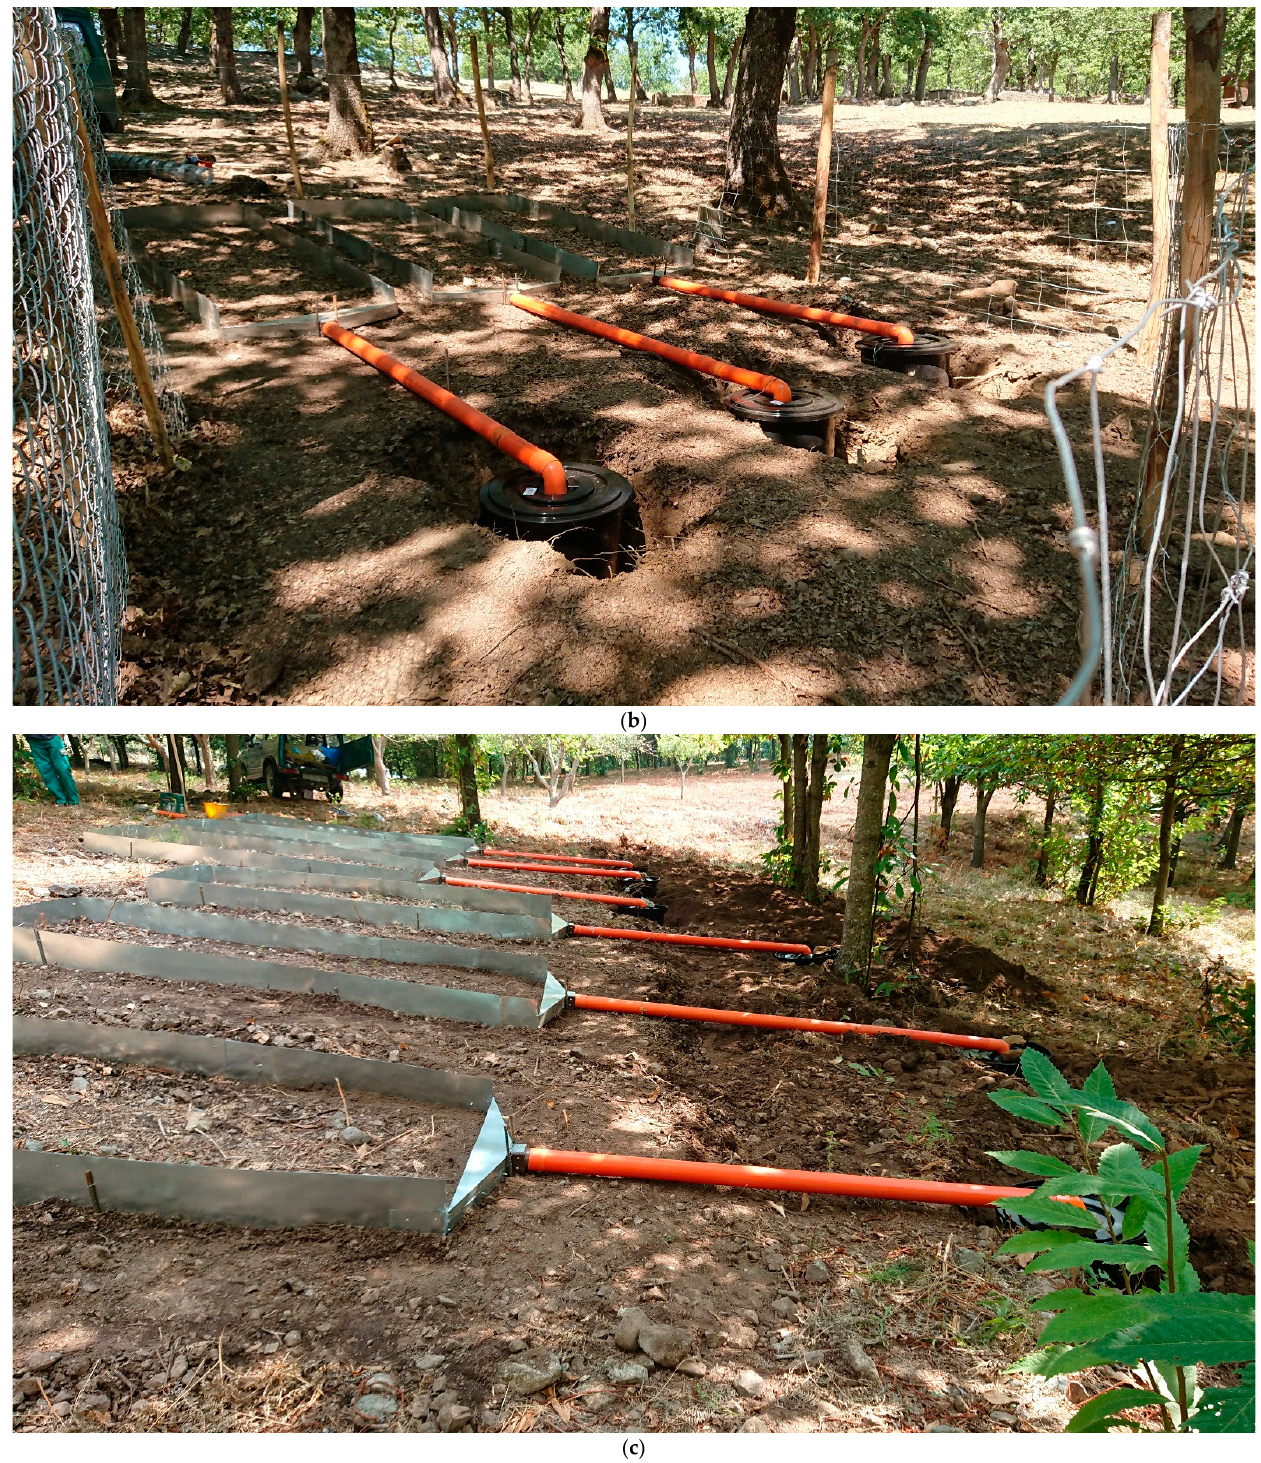
Figure 2. Images of the experimental plots installed for hydrological monitoring of the experimental sites: ( a ) pine; ( b ), oak, and c ), chestnut forests.